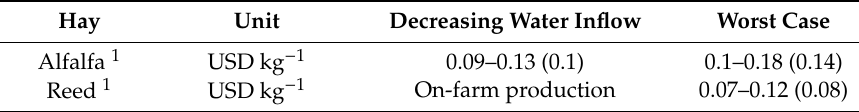
Table 6. Purchase prices for Monte Carlo simulation, ranges, and mean (in brackets) for triangular probability distribution. Conservative estimations based on conducted farm interviews for base year 2015